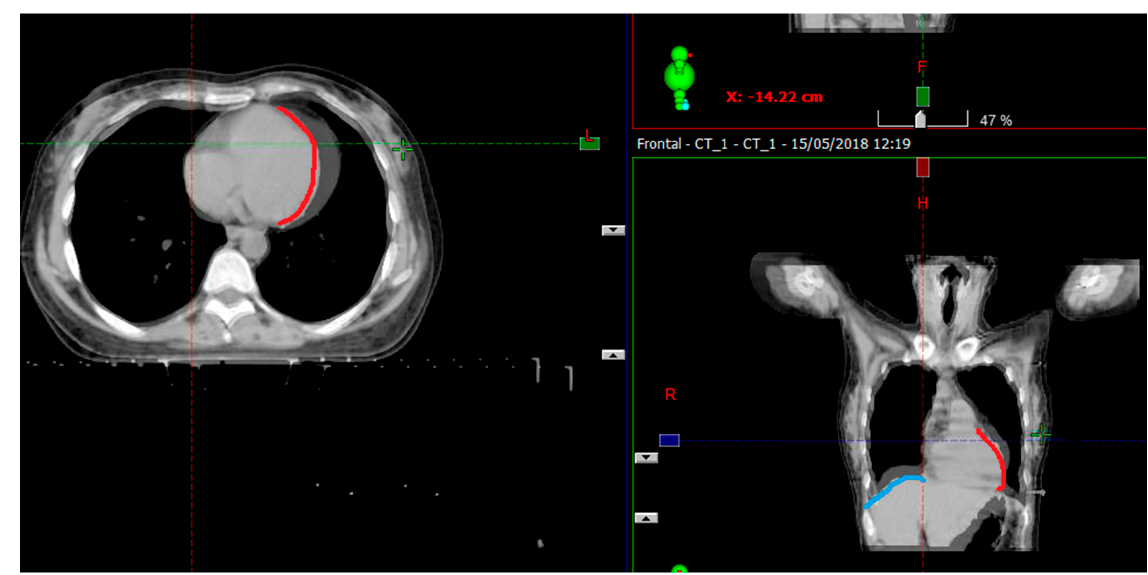
Figure 2. Shows overlay of CPAP and non-CPAP scans. The blue line the difference in diaphragm position and the red line the difference in heart position.